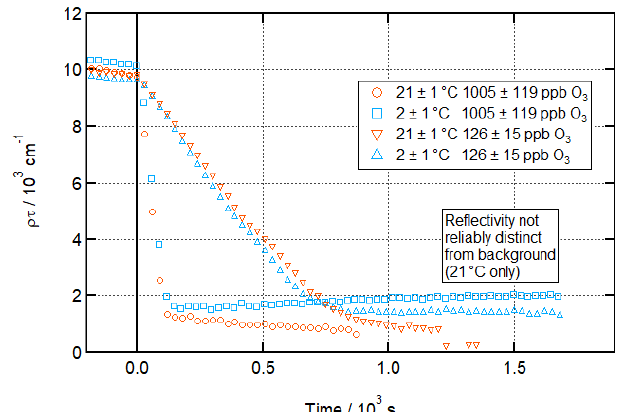
Figure 9. Comparison of time-dependent loss of material from the air–water interface during oleic acid ozonolysis at room and low temperatures and at highest and lowest [O 3 ]. Time evolution plot for ozonolysis of 39µL 0.75gL − 1 d 34 -OA (CHCl 3 spreading solution) on pure subphase by O 3 introduced at t = 0s at 21 ± 1 ◦ C (orange) and 2 ± 1 ◦ C (aqua); error bars are omitted for visual